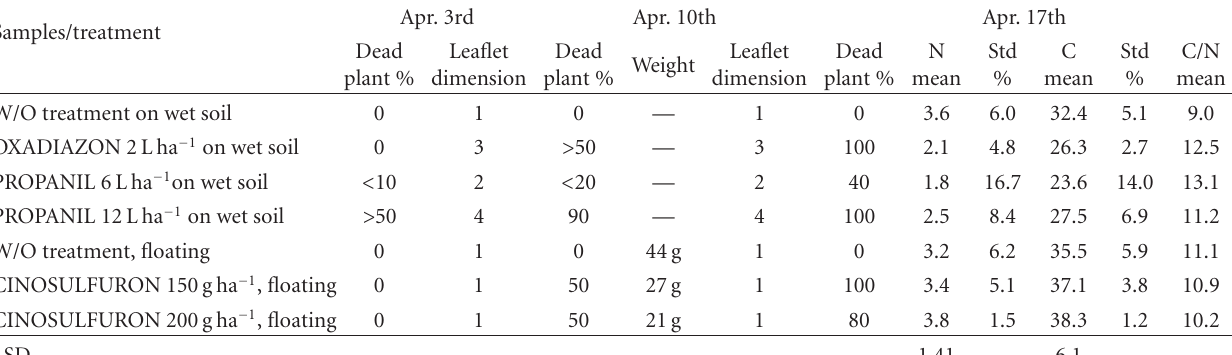
Table 3: Herbicide treatment, Analysis of Nitrogen and Carbon, expressed as d.w. % and fern morphology. Azolla treated directly with herbicides becomes generally stressed, with an associated decrease in N and C content until death ensues. Treatments with 6L/ha of Propanil and Oxadiazon were, from the outset, deleterious for Nitrogen and Carbon accumulation. Treatment with 200 g/ha of Cinosulfuron initially caused no change or only a slight increase in Nitrogen and Carbon content. At 13 days, the fresh weight of the samples treated with Cinosulfuron, had shown slight increase of biomass (initial inoculum = 20 g on Mar. 29th). However, after this intermediate phase Cinosulfuron caused a progressive deterioration leading to the death of the fern. Only Propanil 6Lha − 1 treatment allowed 60% of plants to survive, albeit with reduced quantities of fixed Nitrogen. Leaflet surface: 1 > 2 > 3 > 4. We could weigh only floating samples, in Cinosulfuron treatment. The results of ANOVA (data not showed) performed on the nitrogen and carbon content and their ratio, in the herbicide treated samples show significant di ff erence between treatments for the nitrogen and carbon contents, while di ff erences in C/N ratios are less marked. Table shows LSD (Least Significant Di ff erence).